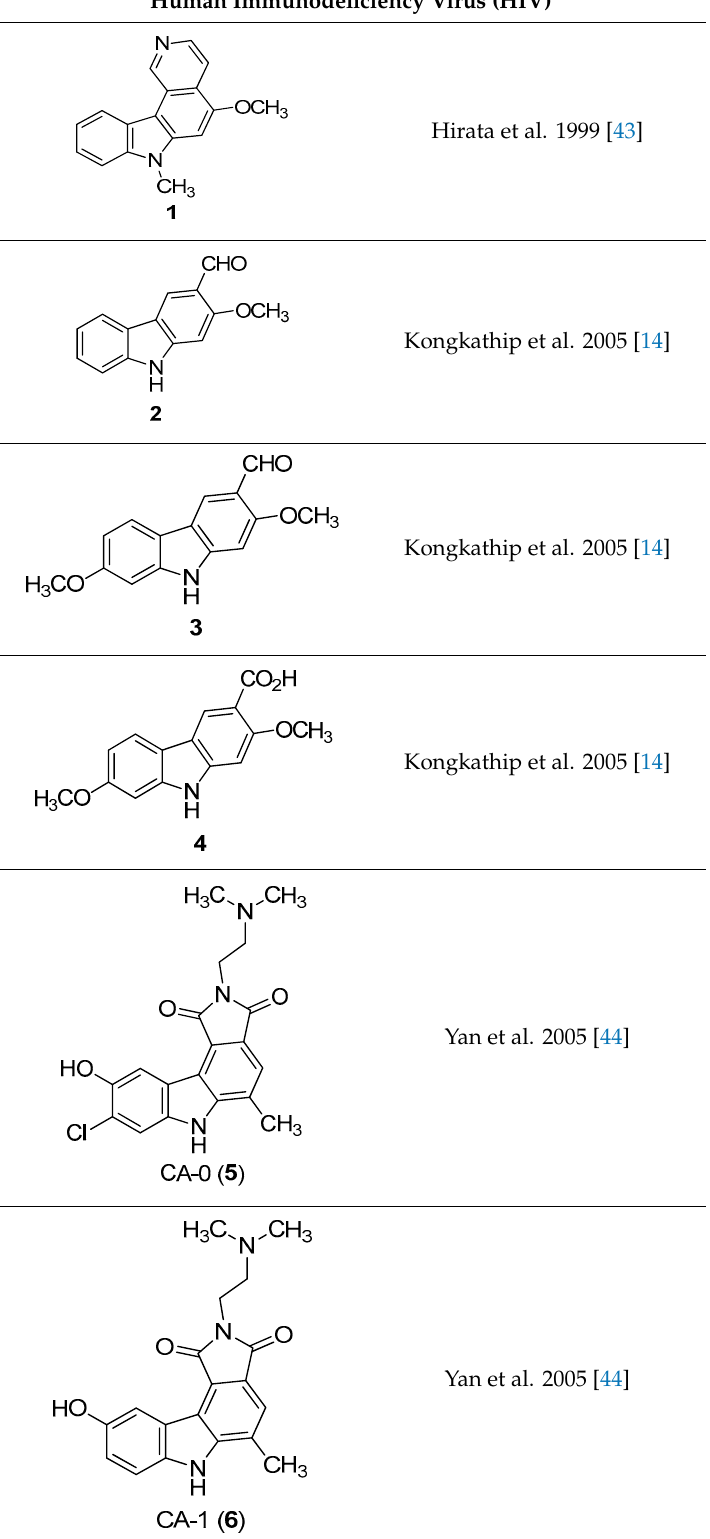
Table 1. Carbazole derivatives as antiviral agents.